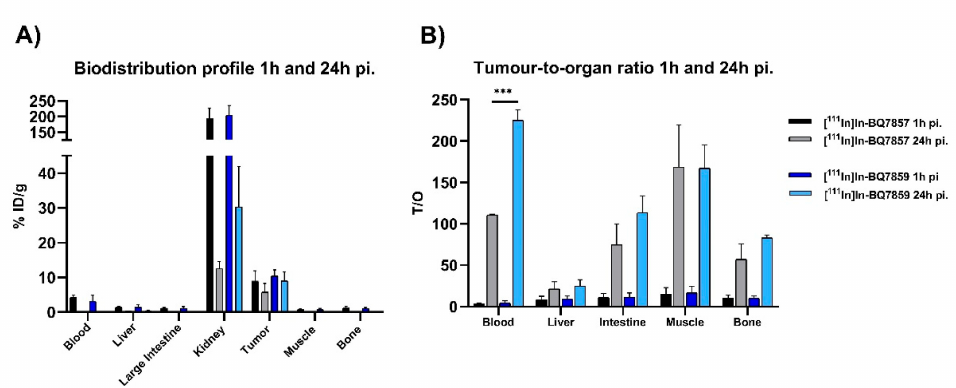
Figure 10. In vivo biodistribution of [ 111 In]In-BQ7857 and [ 111 In]In-BQ7859 in PSMA-expressing PC3-pip tumour-bearing mice at 1 and 24 h post-injection. ( A ) Uptake activity in specified organs. ( B ) Tumour-to-organ ratio (T/O). *** indicate p -value < 0.001. Statistical analysis was done using an unpaired, two-tailed t